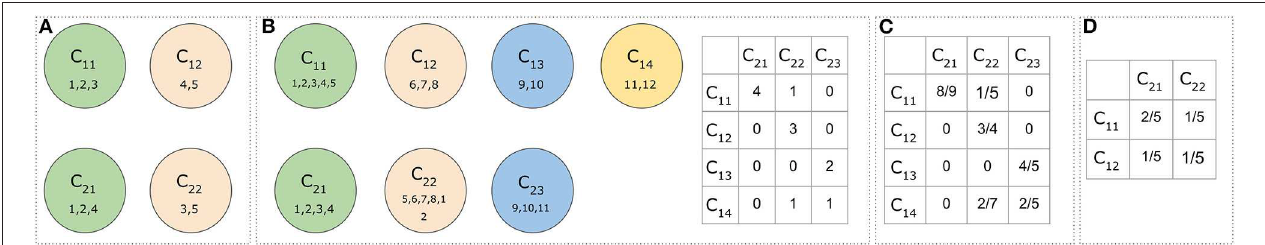
FIGURE 12 | Clustering comparisons. (A) Rand Index between C 1 and C 2 . C 11 and C 12 are clusters 1 and 2 of the C 1 clustering, respectively. One pair [1, 2] is clustered together in both clusterings, three pairs [1, 5], [2, 5], and [3, 4] are clustered differently in both clusterings and the rest six pairs [1, 3], [1, 4], [2, 3], [2, 4], [3, 4], and [4, 5] have been placed together in only one of the two clusterings. The Rand Index between the two clusterings is calculated as = 0.4. (B) Maximum-Match-Measure between C 1 and C 2 . C 1 has four clusters while C 2 has three. At the first iteration the RandIndex ( C 1 , C 2 ) = 2(1 + 3) 5(4) cluster-intersections’ confusion matrix element conf ′ 11 = 4 is chosen and column 1 and row 1 are crossed out. At the second iteration the maximum element of